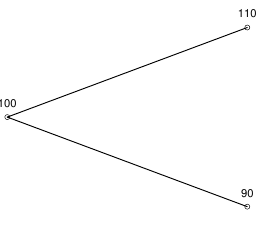
Figure 4. Simple 1-period binomial model of a stock